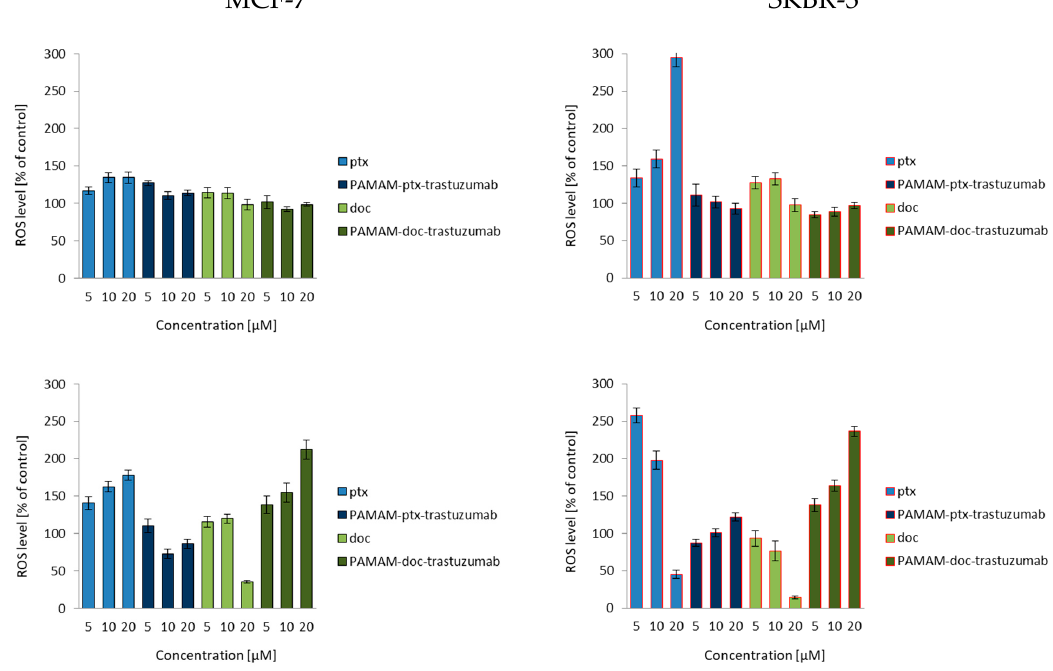
Figure 1. Influence of the PAMAM-ptx-trastuzumab conjugate, PAMAM-doc-trastuzumab conjugate, paclitaxel (ptx) and docetaxel (doc) at a concentration range of 5–20 µ M on the ROS generation in MCF-7 cells ( left panel ) and SKBR-3 cells ( right panel ) after 3 and 24 h incubation periods. The results are presented as the mean ± standard deviation of three experiments.